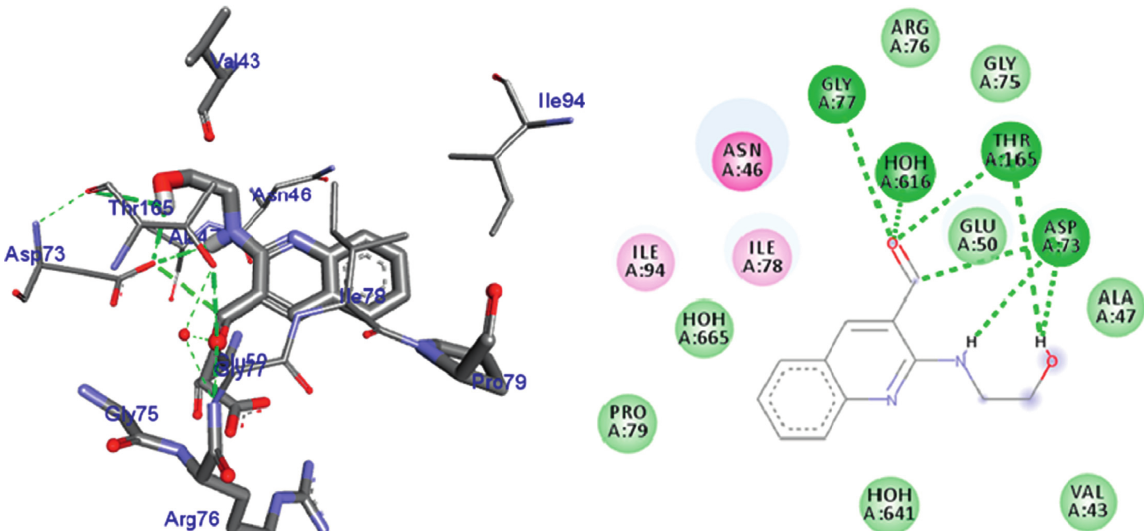
Figure 9: The binding interactions of 17 against E. coli DNA gyrase A (PDB ID: 6F86).